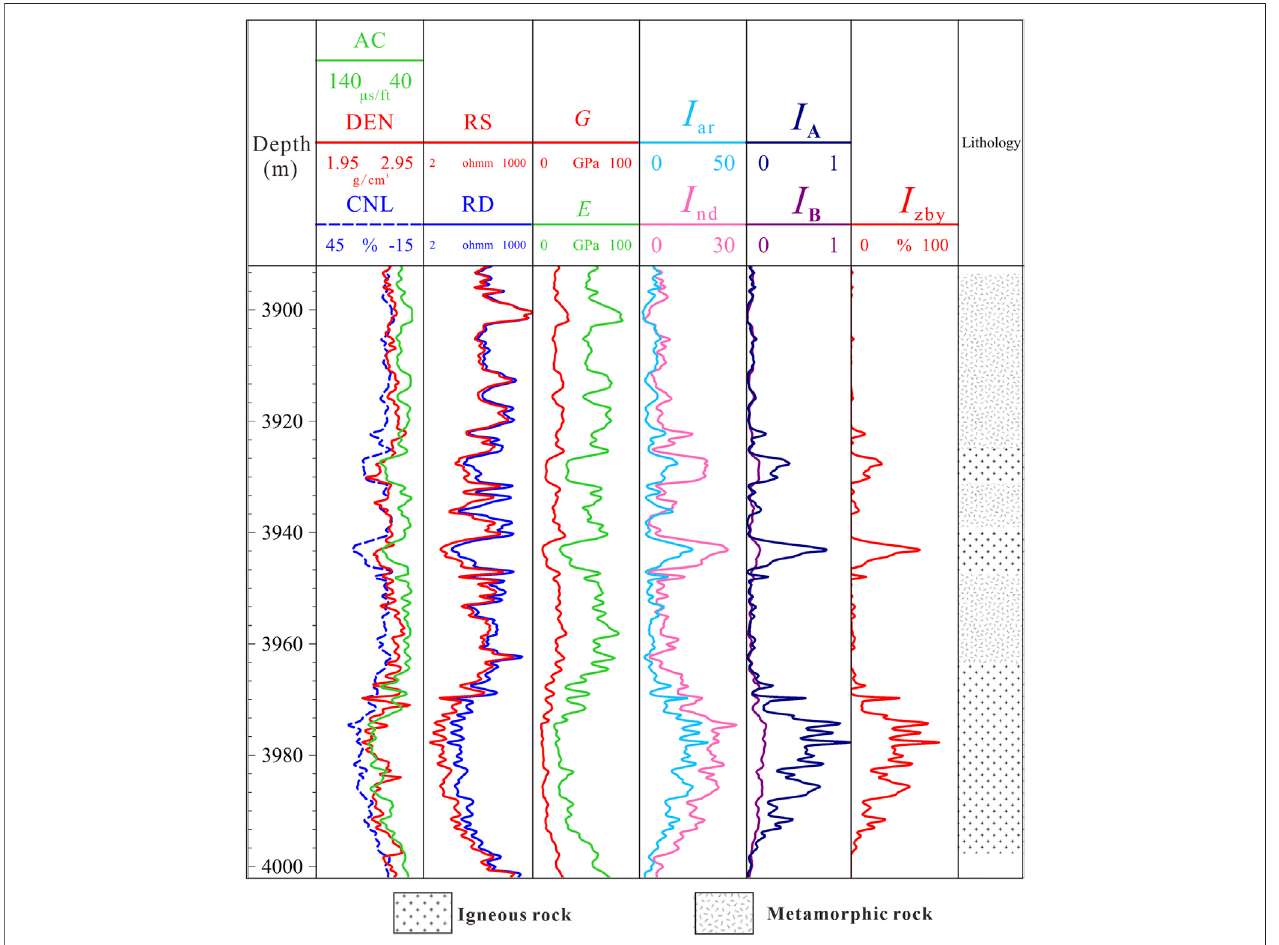
FIGURE4| Degreeofhydrothermalalterationofburiedhillformation.Loggingcurvesandrockmechanicsparametersindicatethedegreeofalterationaccordingto the peak size.